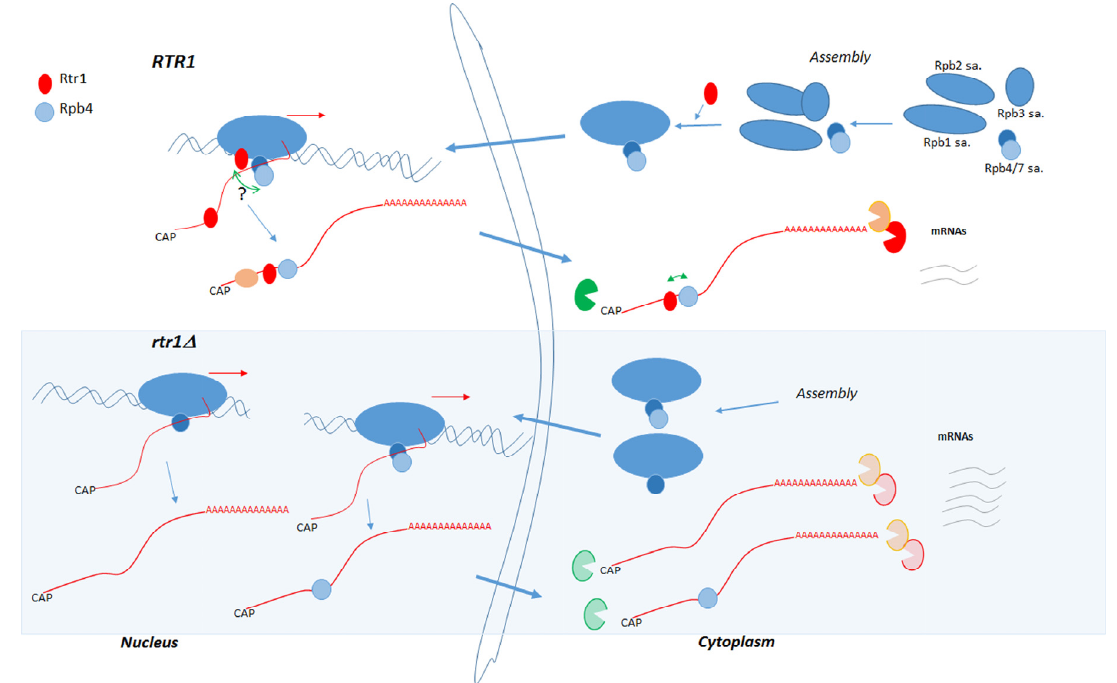
Figure 8. Model for Rtr1 role in RNA pol II cytoplasmic assembly and for Rtr1 and Rpb4 cooperation in mRNA decay. In cytoplasm, Rtr1 would act in RNA pol II assembly to facilitate association Rpb4/7 subassembly complexes in final RNA pol II biogenesis steps. Complete RNA pol II, or that lacking Rpb4 (under RTR1 deletion), would be transported to nucleus, likely by an Iwr1-dependent pathway. We cannot rule out that Rtr1 also acts by promoting nuclear association of Rpb4 with rest of enzyme. In the nucleus, Rtr1 would associate with RNA pol II and would cotranscriptionally imprint mRNA in cooperation with Rpb4, which also imprints mRNA cotranscriptionally. RTR1 deletion would affect RNA pol II biogenesis and Rpb4 association with rest of enzyme, as well as transcription mediated by RNA pol II, and Rtr1- and Rpb4-mRNA imprinting. Consequently, lack of Rtr1 would lead to altered imprinted mRNAs, which would be exported to cytoplasm and would increase their mRNA stability by altering actions of 3 (cid:48) and 5 (cid:48) mRNA degradation